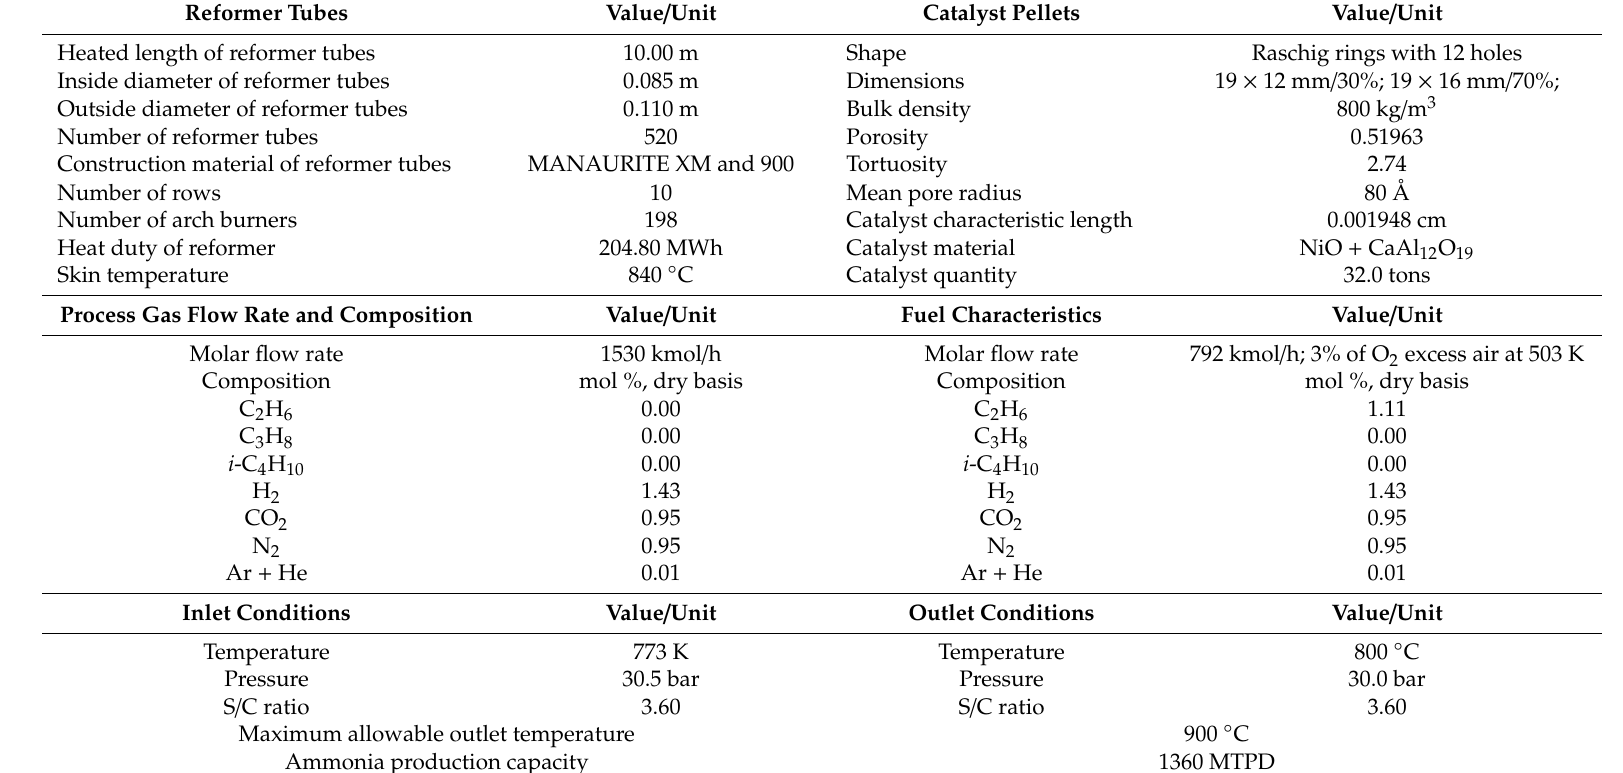
Table 3. Summary of process data of the top-fired